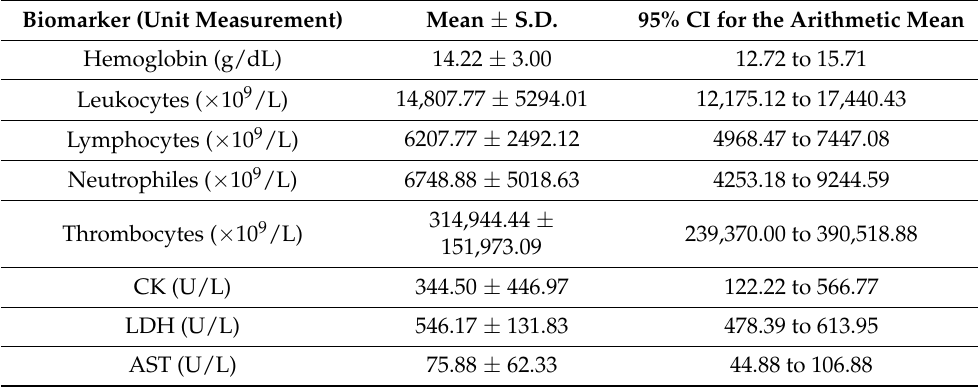
Table 4. The biomarkers and paraclinical data of neonates with COVID-19 pneumonia presented as mean ± S.D and 95% CI for the arithmetic